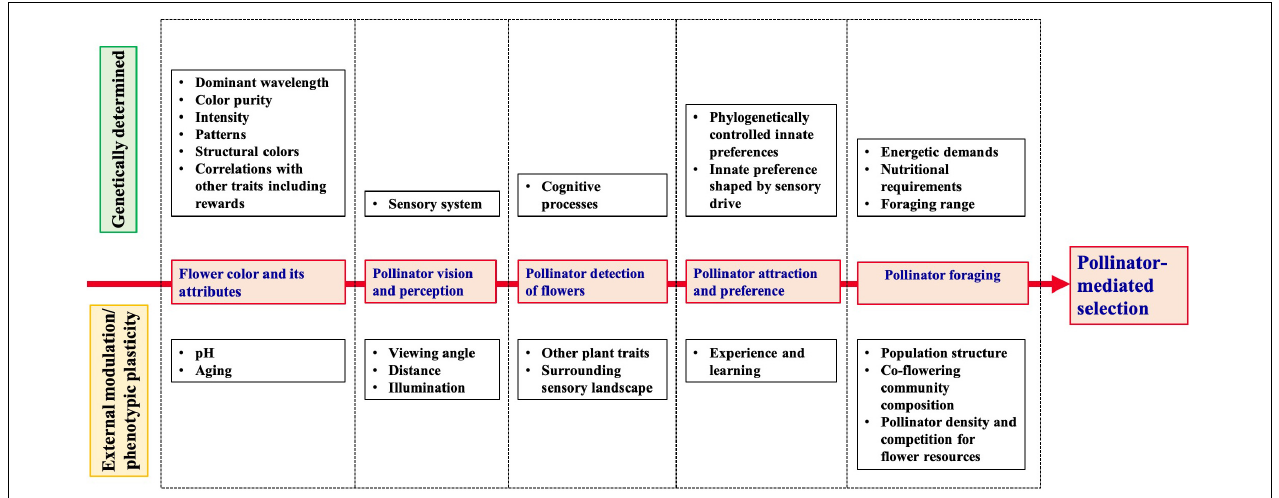
FIGURE 1 | Schematic overview of the successive ways in the interaction of plants and pollinators involving flower colors, and how they impact on the outcome of pollinator-mediated selection on flower